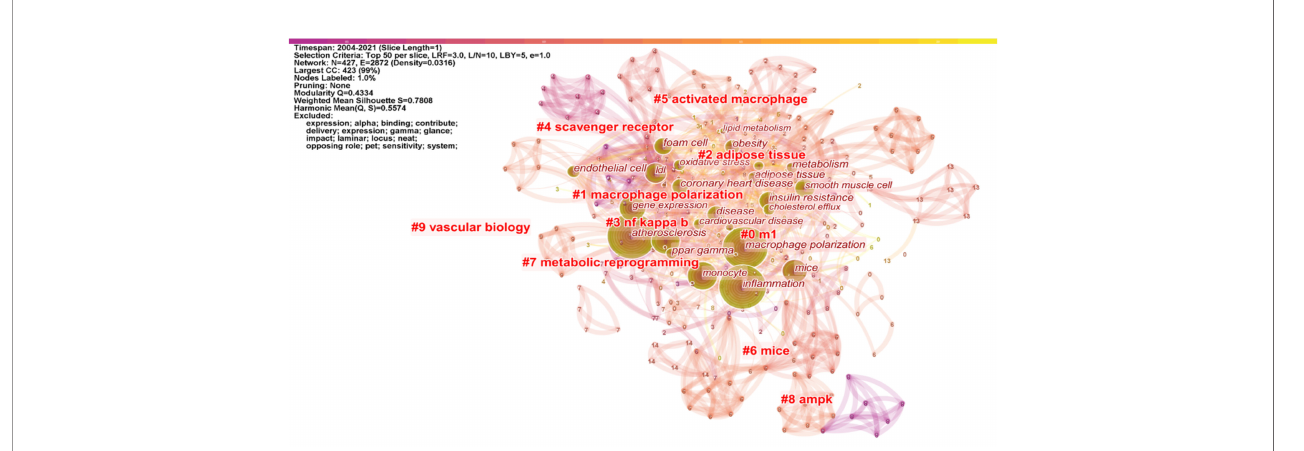
FIGURE 6 | Keyword co-occurrence map and cluster of macrophage polarization in AS